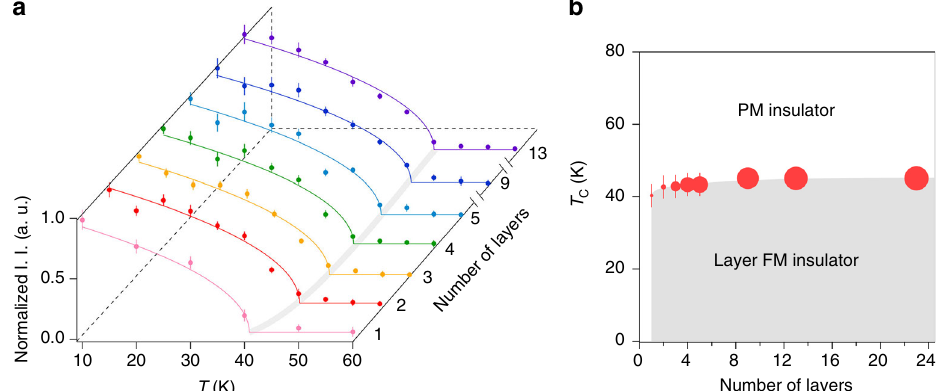
Fig. 4 Temperature versus layer number phase diagram of the 2D layer ferromagnetic CrI 3 . a Temperature dependence of I. I. of the M 2 magnon normalized to the value at 10 K as a function of layer number. The colored solid curves are fi ts to I 0 þ I the evolution of T C . Error bars correspond to the two SEs of normalized I. I. in the Lorentzian fi ts at individual temperatures for different thicknesses of 2D CrI 3 . b Temperature versus layer number phase diagram (PM for paramagnetism and FM for ferromagnetism). The size of the data points represents the M 2 magnon lifetime. Error bars correspond to the two SEs of T C in the fi ts in